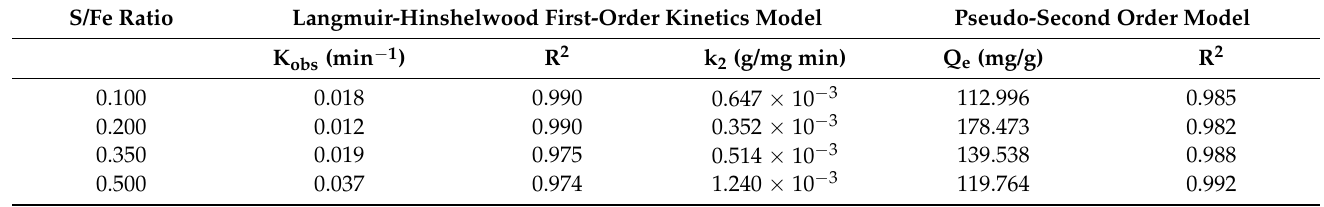
Table 1. Kinetic parameters of Langmuir-Hinshelwood first-order kinetics model and pseudo-second- order kinetics model of S-nZVI@OS with different S/Fe ratios. S/Fe Ratio Langmuir-Hinshelwood First-Order Kinetics